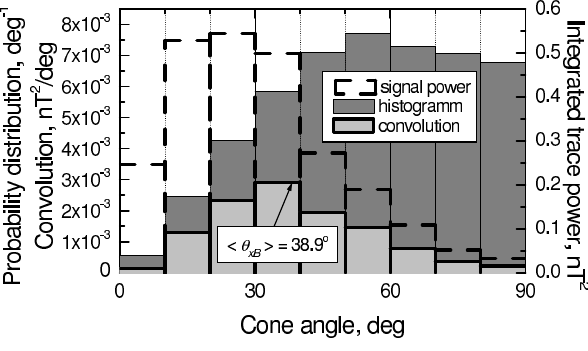
Fig. 12. Band-limited signal trace power vs θ xB (dashed line), cone angle (dark shading), and their convolution (light shading). See comments in